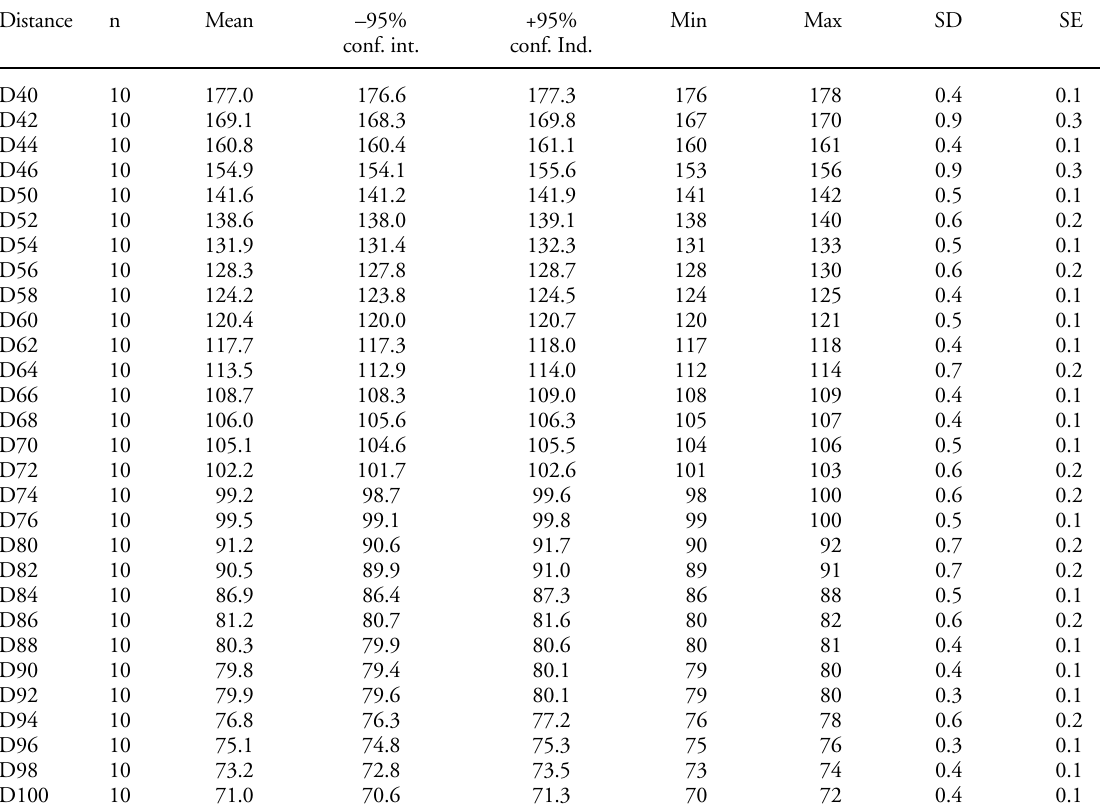
Table 1. Mean and dispersion measures for the human error in the measurement of the number of pixels included in a cardboard elephant silhouette at the various distance intervals considered in this study. Symbols: D40 = distance of 40 m, etc. Distance n